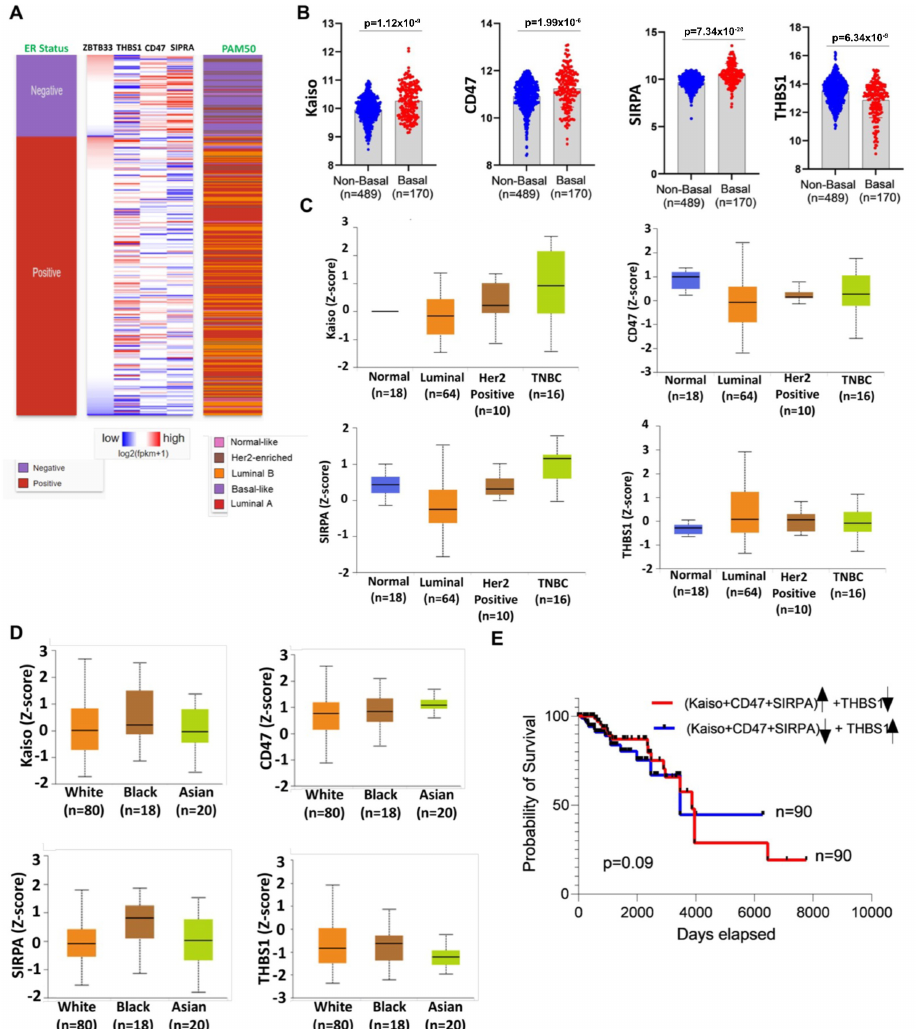
Figure 6. TCGA data validate the increased expression of Kaiso and CD47, with decreased expression of THBS1 correlating with TNBC breast cancer patients and linked with AA race. ( A ) High expression of Kaiso, CD47, SIRPA, and low expression of THBS1 was correlated with Basal-like BRCA and ER-negative patients. ( B ) Kaiso, CD47, and SIRPA expressed highly in Basal like patients as compared to non-basal patients, whereas THBS1 expression was deceased in Basal like patients as compared to non-basal patients. ( C ) The higher level of protein for Kaiso, CD47, and SIRPA and lower level of THBS1 observed in BRCA TNBC samples as compared to other subtypes collected from the PANCAN RPPA dataset. ( D ) The higher level of protein for Kaiso, CD47, and SIRPA in AA patient samples as compared to other races. ( E ) TCGA survival analysis identified that a high level of combined Kaiso, CD47, and SIRPA with a low level of THBS1 (Red line) indicate even poorer patient survival in AA BRCA patients compared to a low level of combined Kaiso, CD47, and SIRPA with a high level of THBS1 (Dark blue